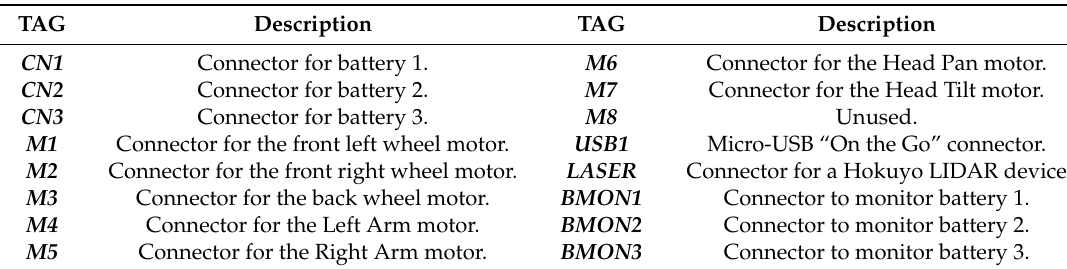
Table 1. Description of the MCB connectors.